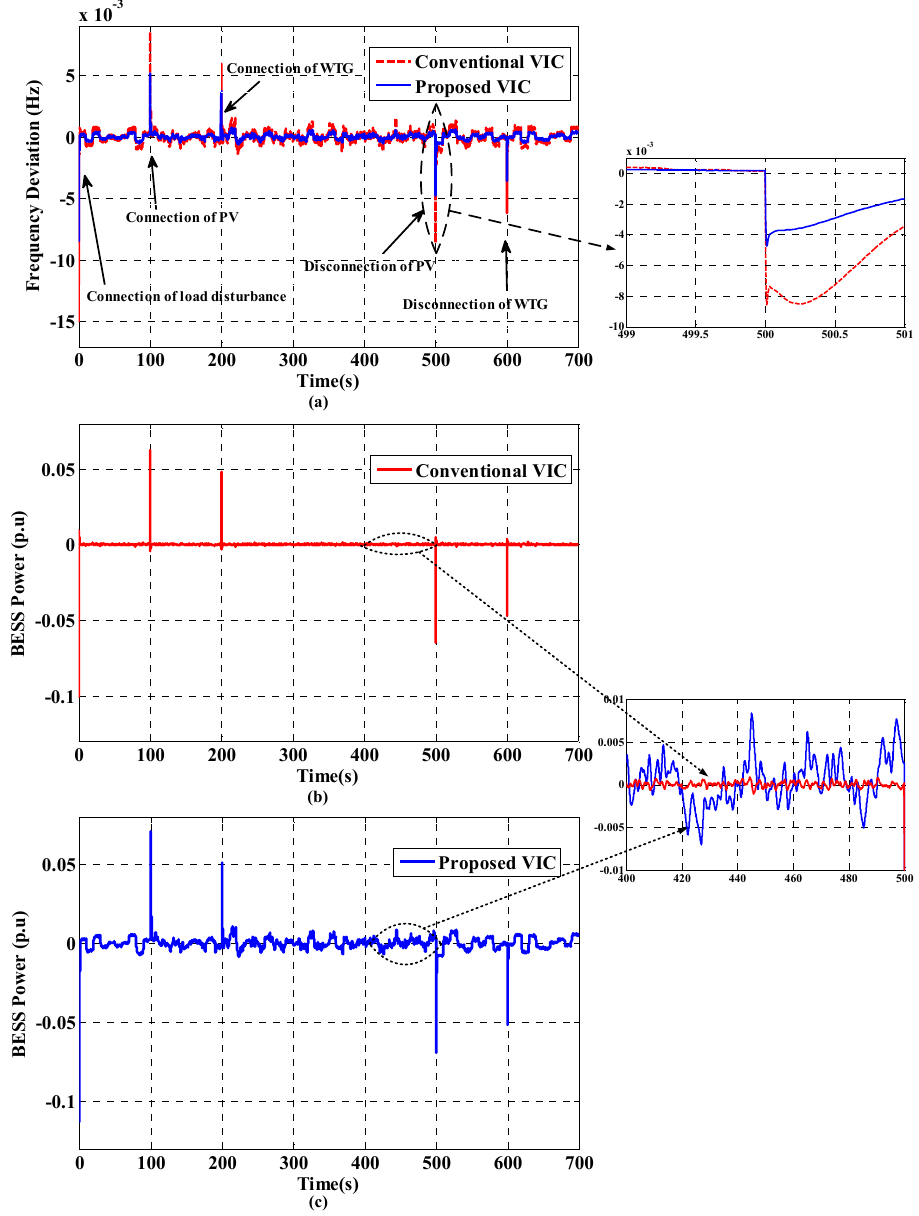
Figure 15. MG dynamic responses for scenario in Section 5.2.2.2. ( a ) Resulted frequency responses. ( b ) Power of conventional VIC-based BESS. ( c ) Power of proposed VIC-based BESS.